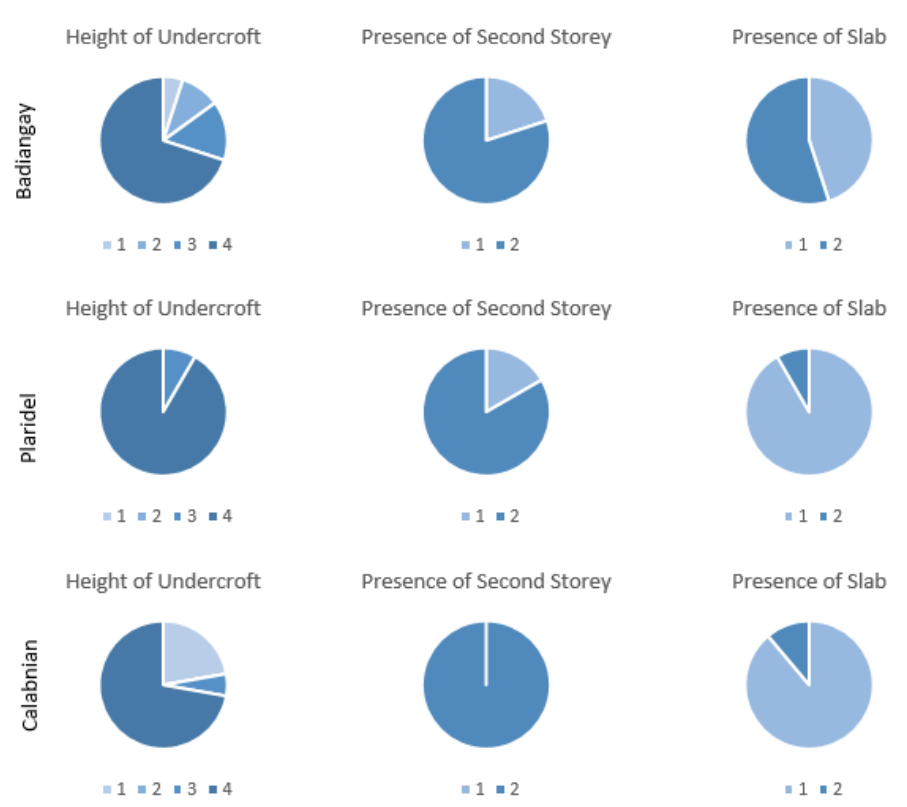
Figure 13. Vulnerability indicator distribution for flood hazard across three locations: Badiangay, Plaridel, and Calabnian.